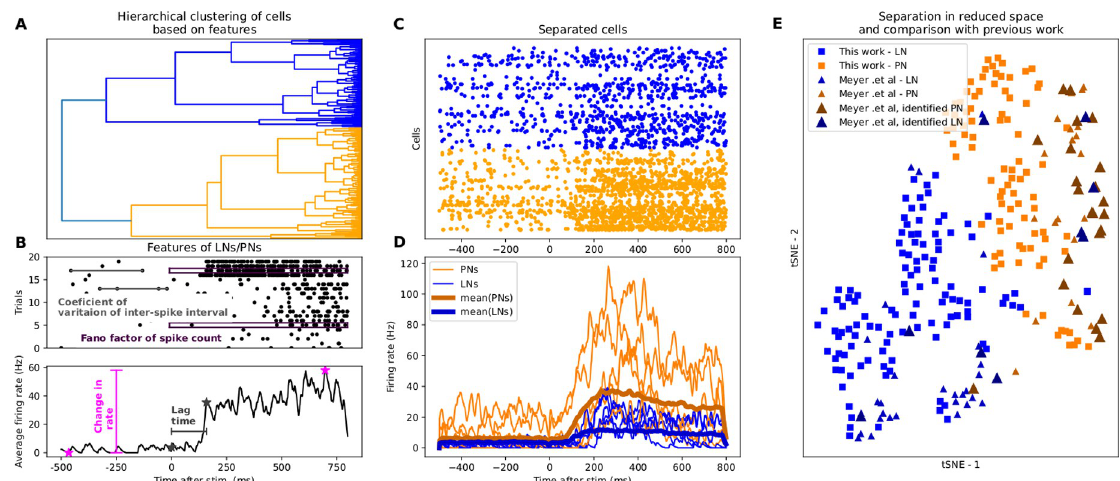
Fig 2. Separation of PNs and LNs using a statistical procedure outlined in [1]. ( A ) Separation of LNs and PNs using hierarchical clustering (see Methods) into LNs (blue) and PNs (orange). ( B ) Explanation of cell-based features used for clustering (see Methods) based on spike times (top) and response rate (bottom). ( C ) Spike rasters and, ( D ) firing rate time courses of separated cells. ( E ) Cell-based features visualized in reduced space using tSNE (t-distributed Stochastic Neighbor Embedding) [4].